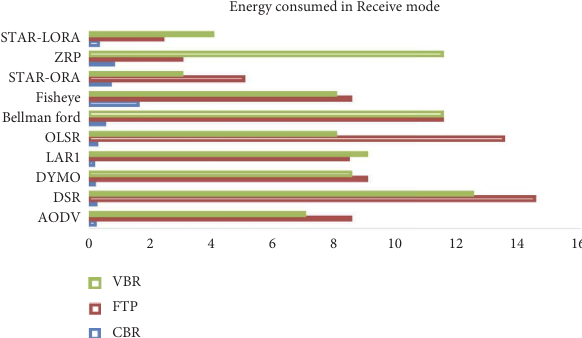
Figure 14: Receive mode energy consumption of all routing protocols for 60 nodes.